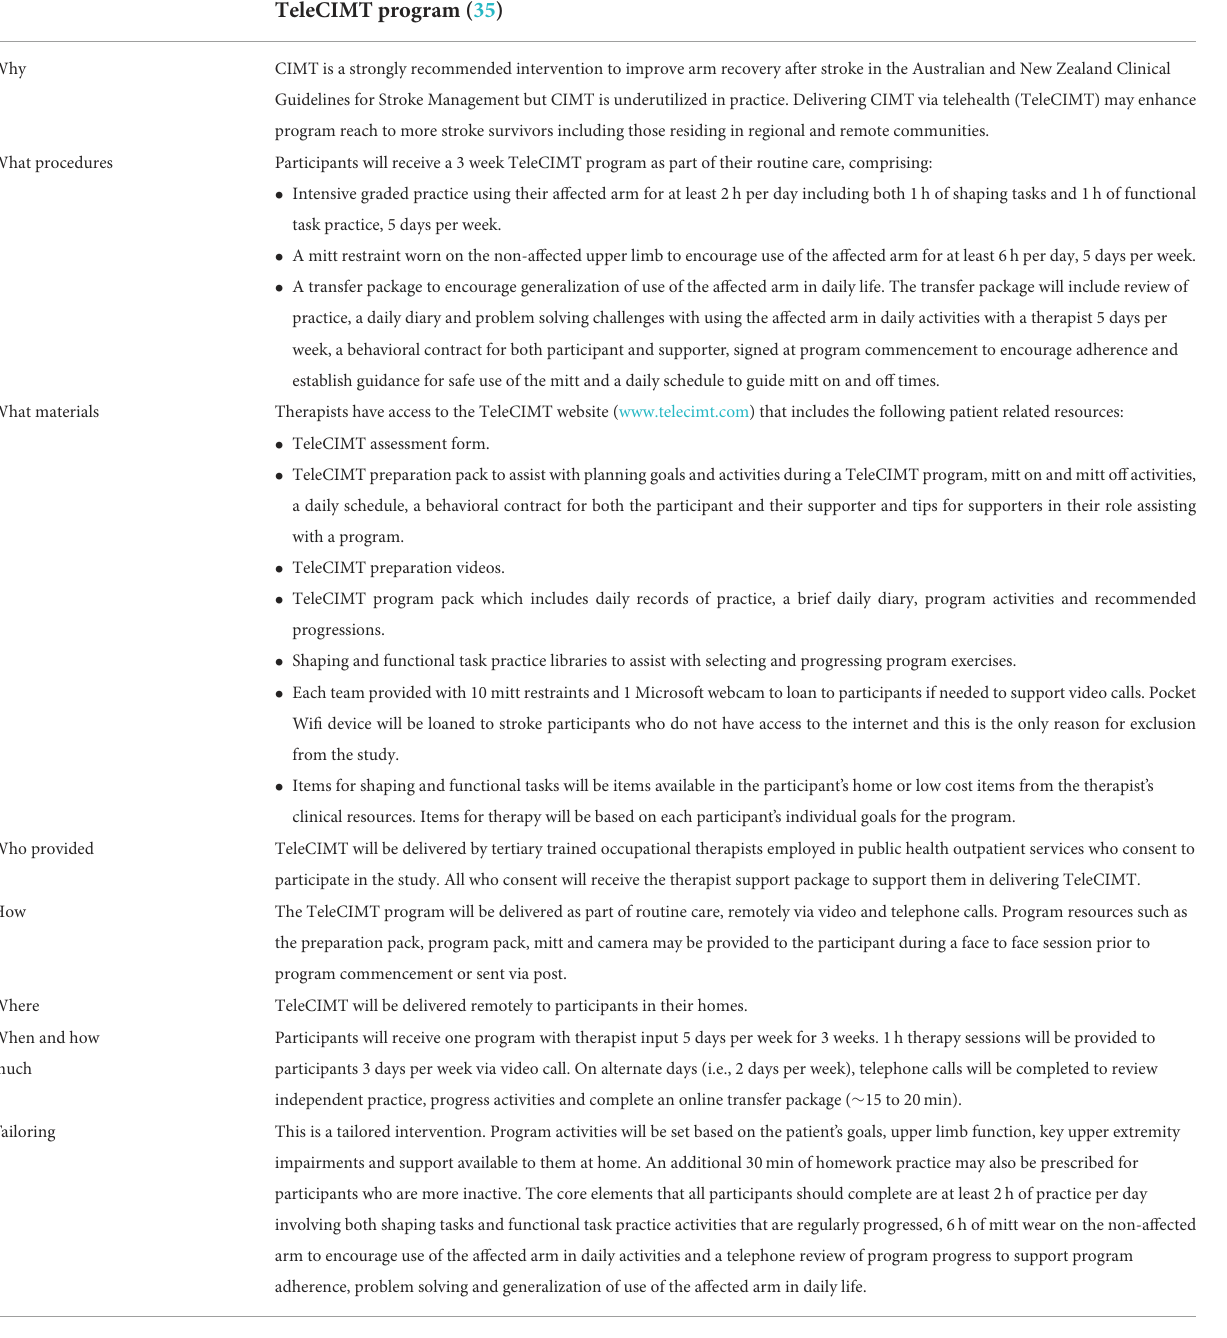
TABLE 2 TeleCIMT intervention description using the Template for Intervention Description and Replication (TIDIeR) checklist (39). TeleCIMT program